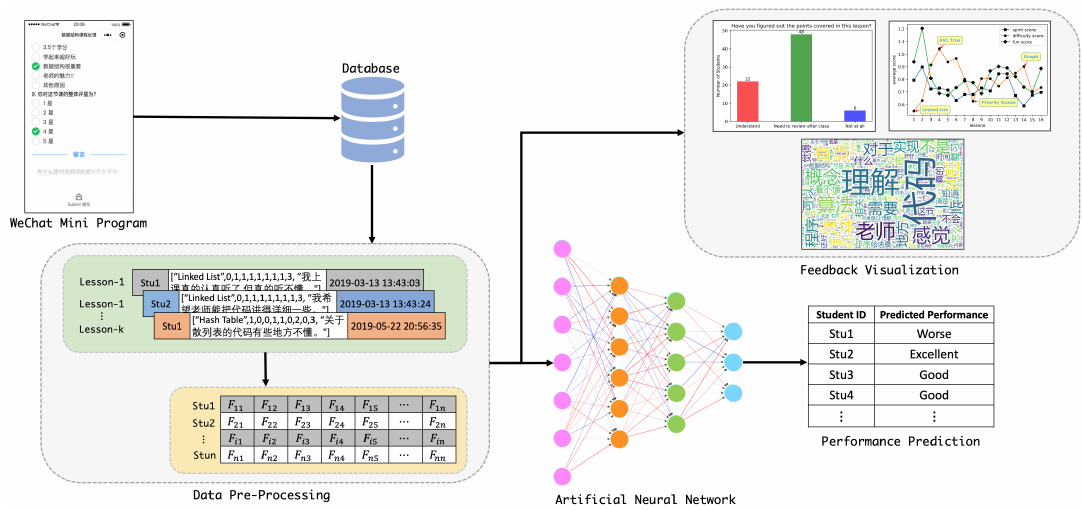
Figure 2. The architecture of the proposed system.